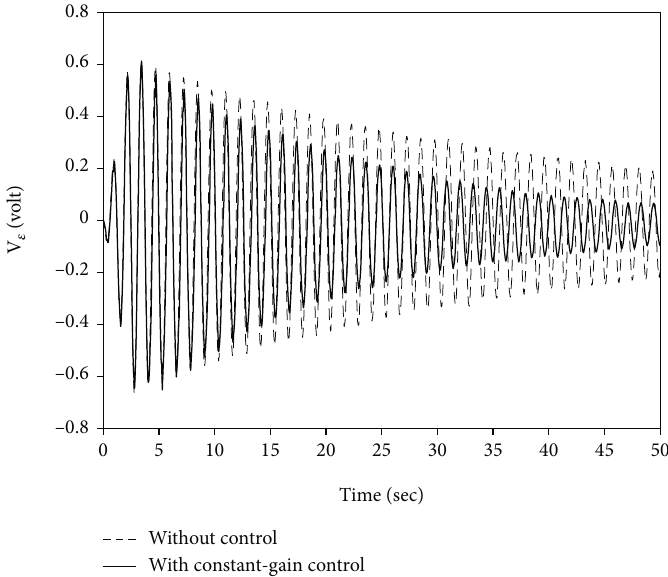
Figure 10: Measured response curve of the strain voltage with constant-gain control.